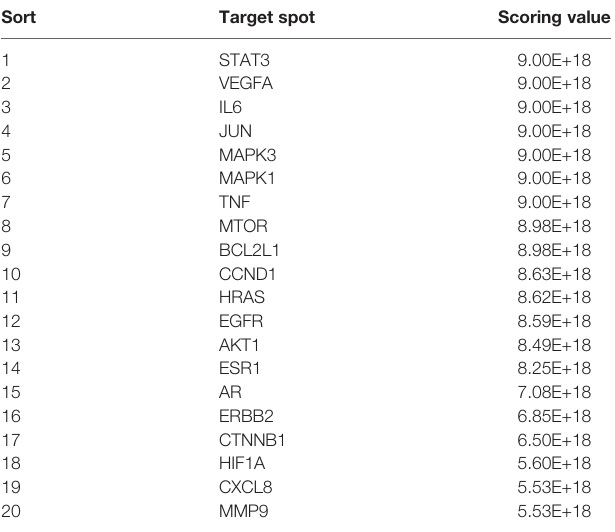
TABLE 1 | Degree information of top 20 targets.